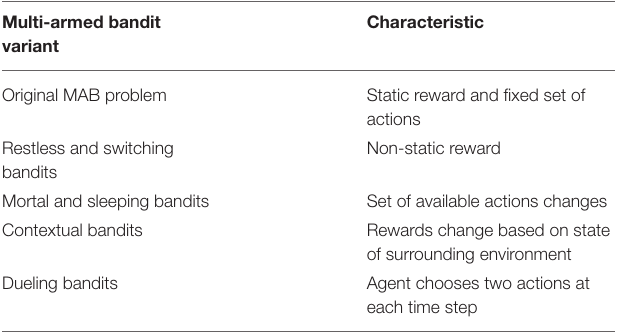
TABLE 1 | Overview of MAB variants and their characteristics compared to the original MAB